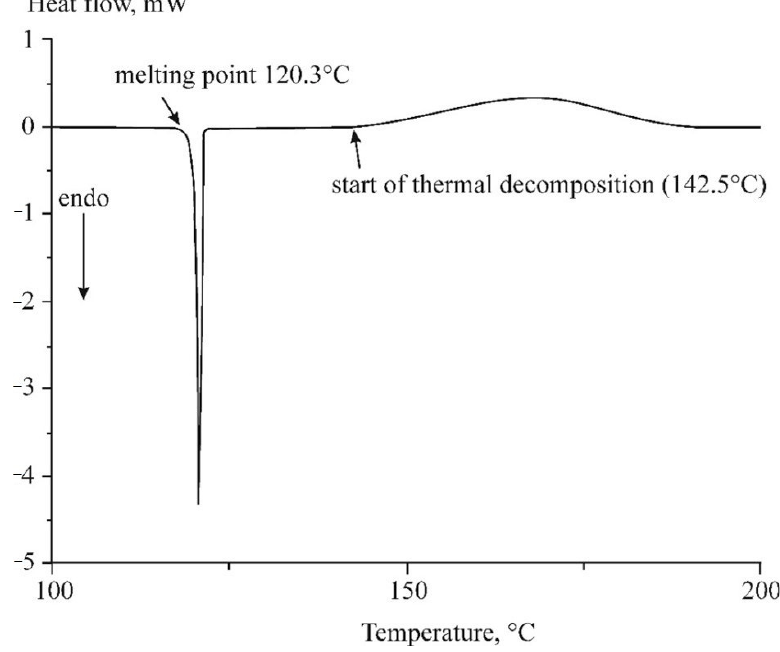
Figure 2. DSC thermogram of 3-(5-phenyl-2 H -tetrazol-2-yl)pyridine 1 .